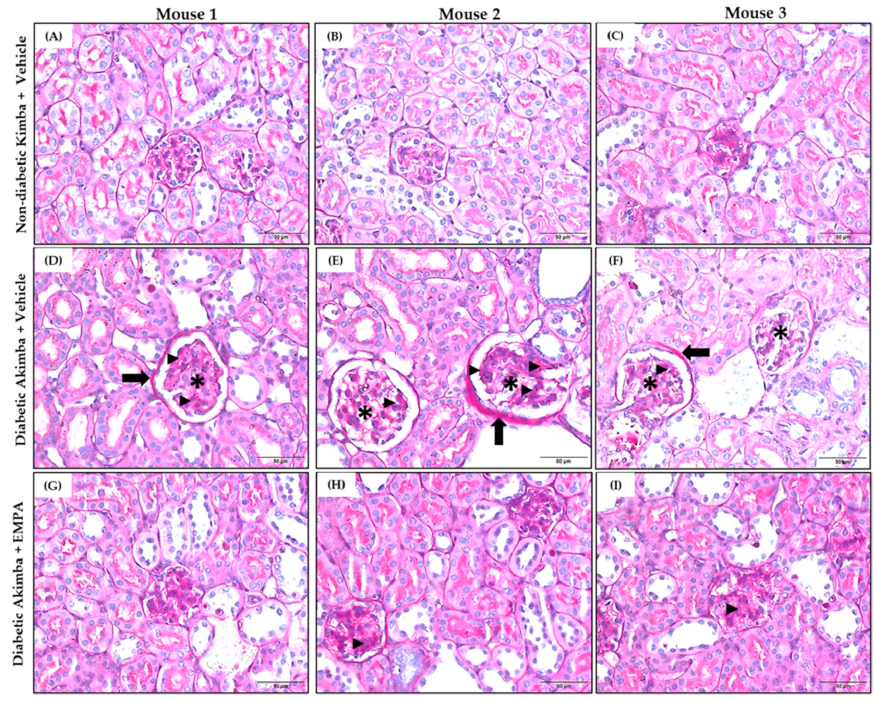
Figure 11. Representative images of Masson’s Trichrome-stained kidney tissues from